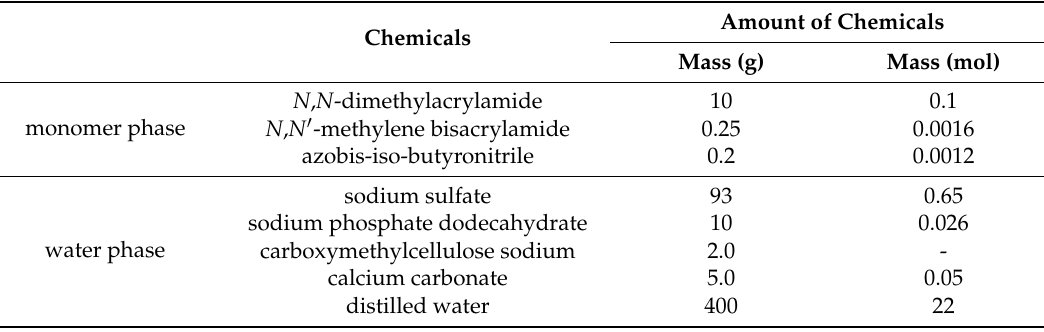
Table 1. Preparation condition of spherical